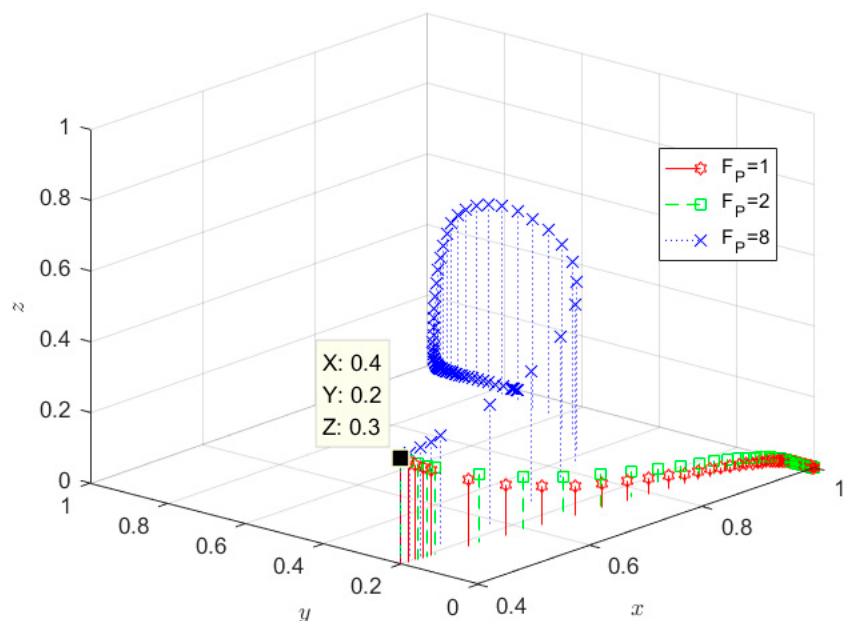
Figure 9. Impact of government fines for wastewater producers who take non-ecological behav- iours.